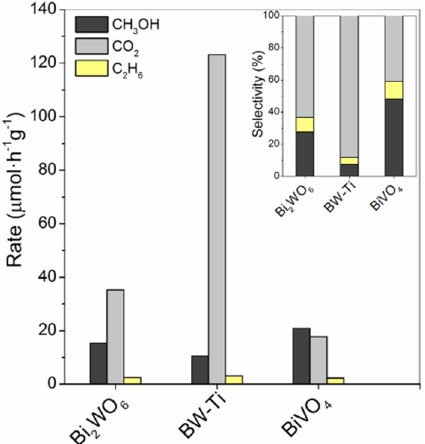
Figure 15. Photocatalytic activity of several bismuth-based photocatalysts [65]. Reproduced with permission from López et al. Copyright © 2022 ACS Publications.